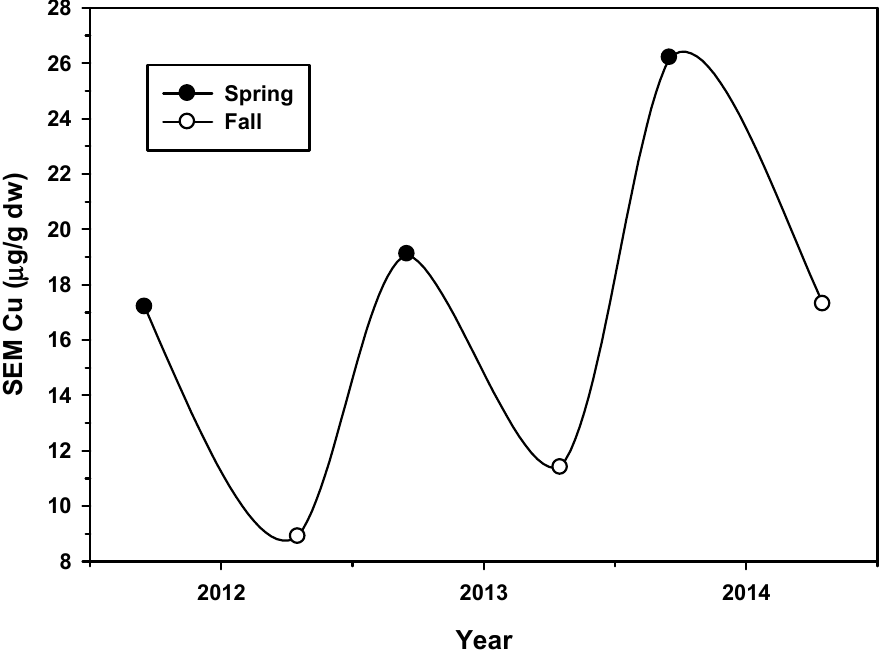
Figure 11. SEM copper concentrations (µg/g dry wt) from spring and fall sediment sampling at Cache Slough site CS-10 for the years 2012, 2013 and 2014.